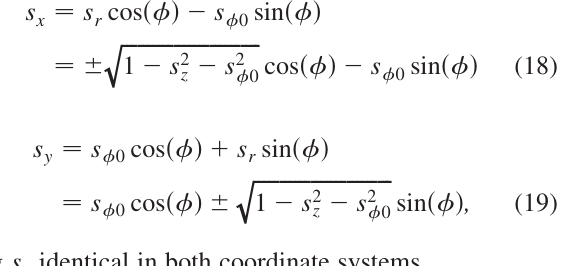
ffiffiffiffiffiffiffiffiffiffiffiffiffiffiffiffiffiffiffiffiffiffiffiffiffiffiffi